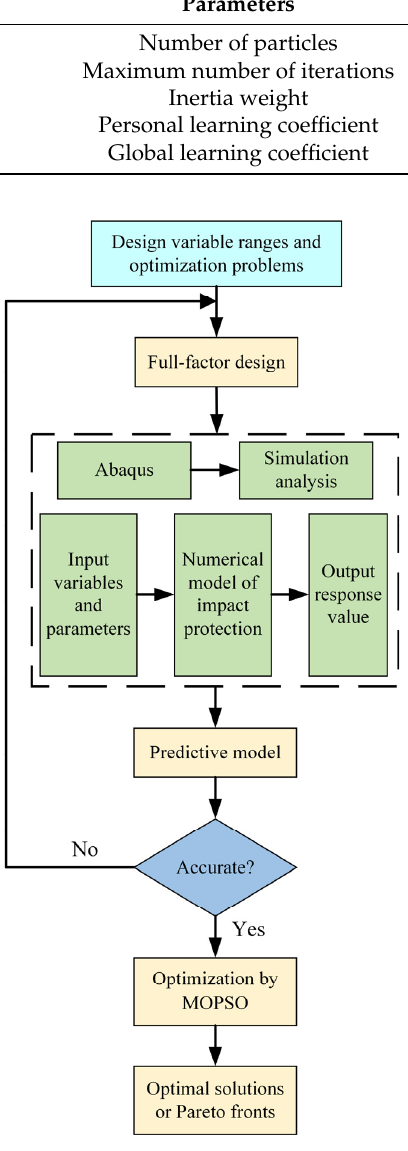
Figure 12. Optimization design flow chart.